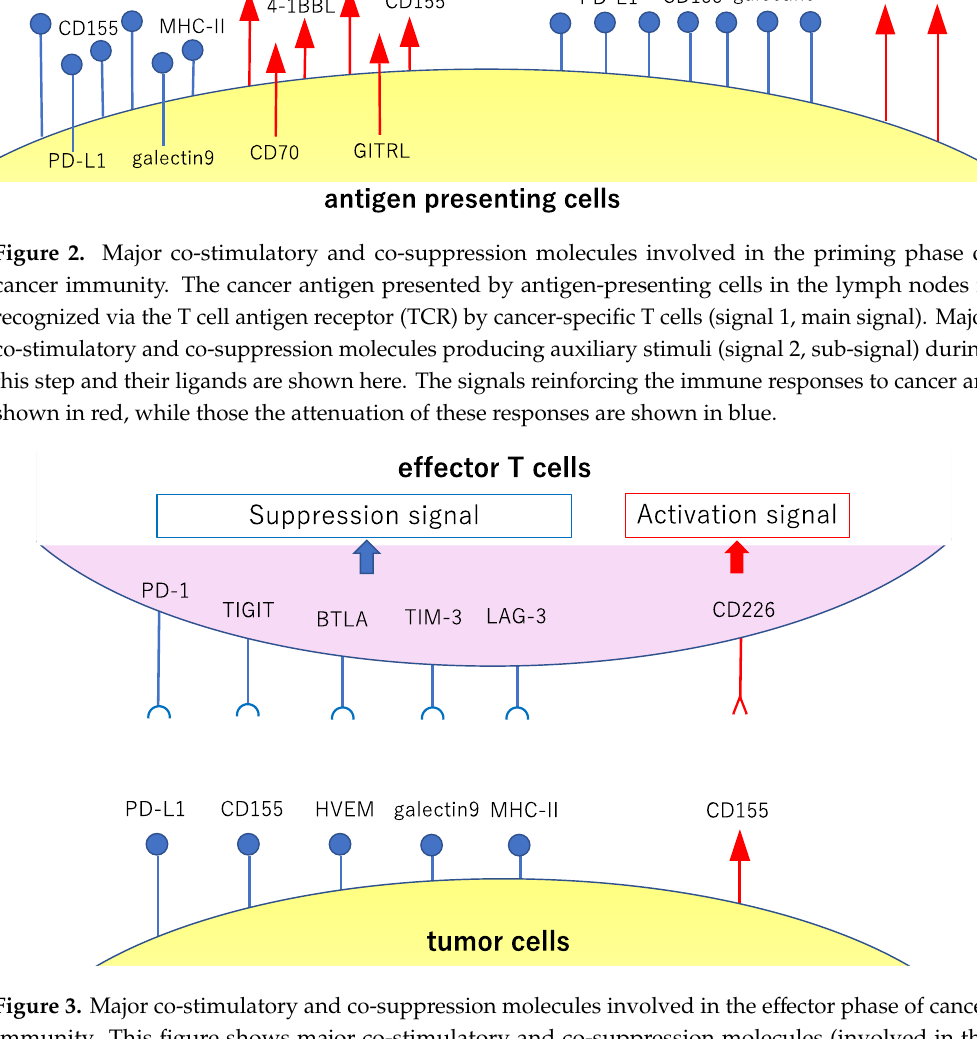
Figure 3. Major co-stimulatory and co-suppression molecules involved in the effector phase of cancer immunity. This figure shows major co-stimulatory and co-suppression molecules (involved in the attack against the cancer cells by activated and proliferated effector T cells after antigen presentation and recognition) and their ligands. The signals reinforcing the immune responses to cancer are shown in red, while the signals causing attenuation of such responses are shown in blue.